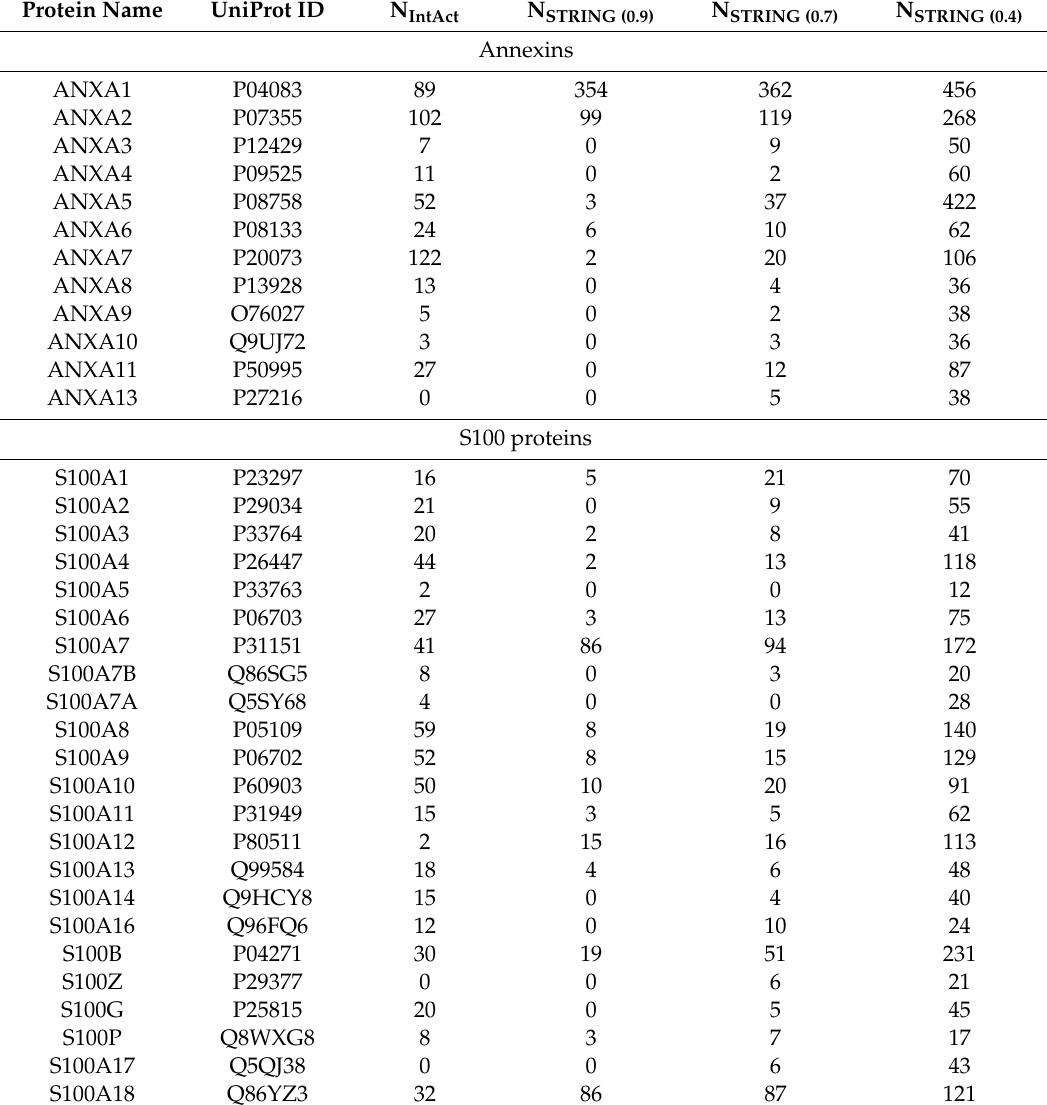
Table 1. Evaluating interactability of human annexins and S100